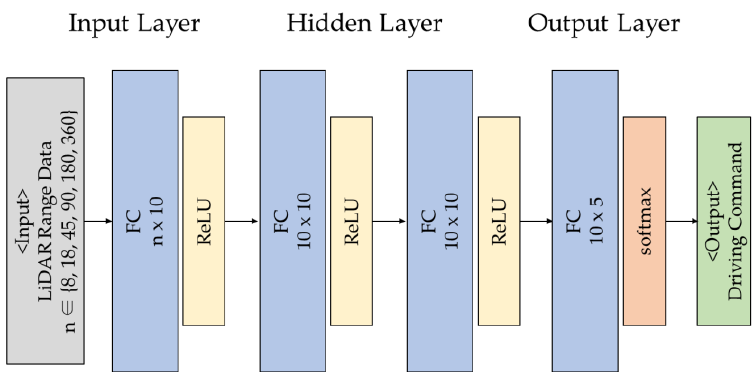
Figure 7. Neural Network Model for Indoor Autonomous Driving.